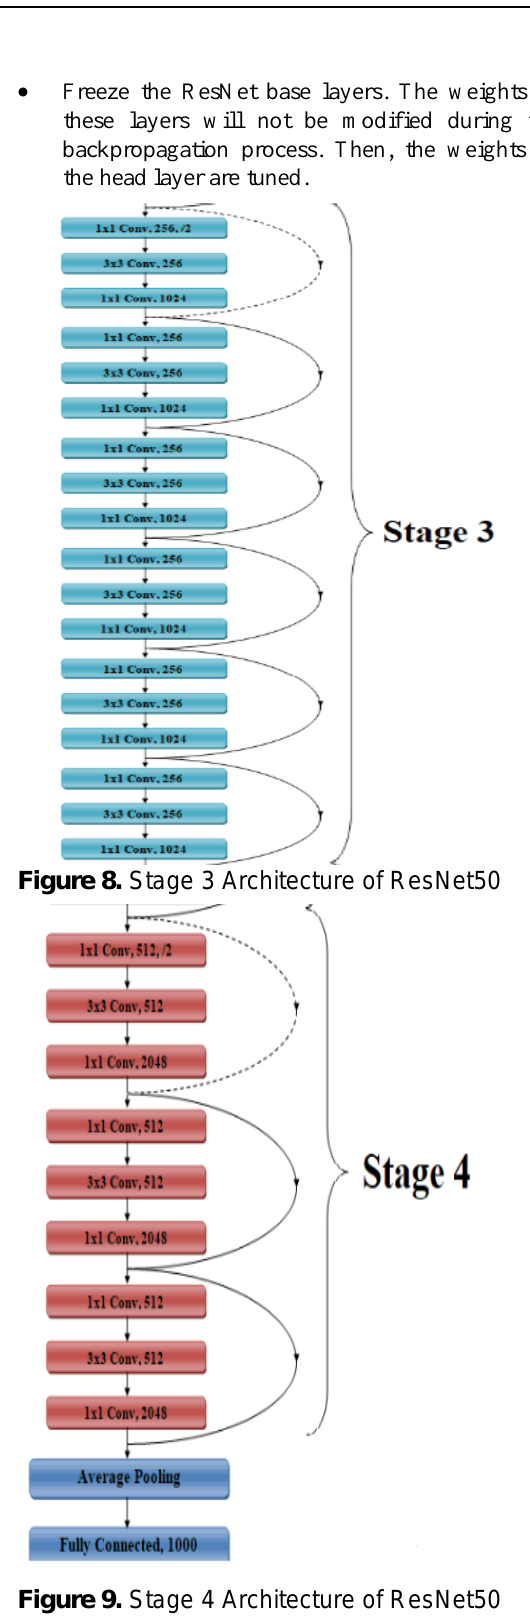
Figure 9. Stage 4 Architecture of